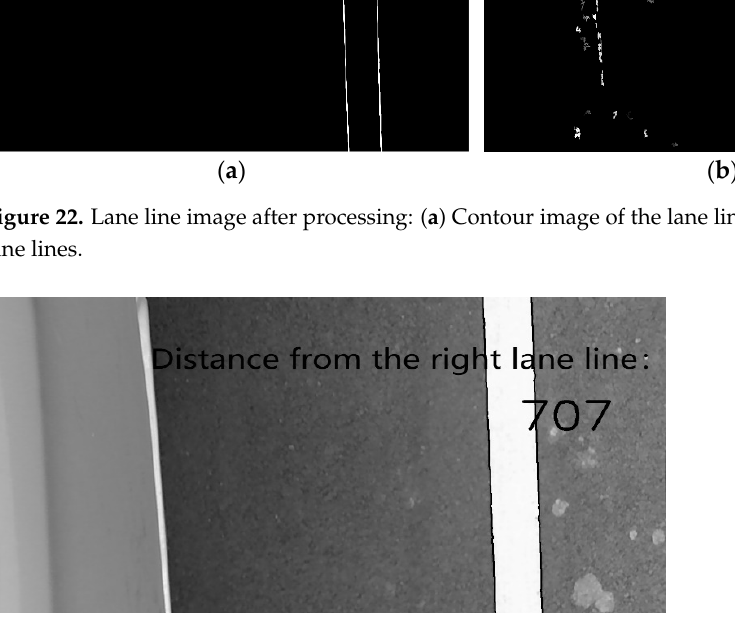
Figure 23. Distance between vehicle and lane line measured by binocular camera when